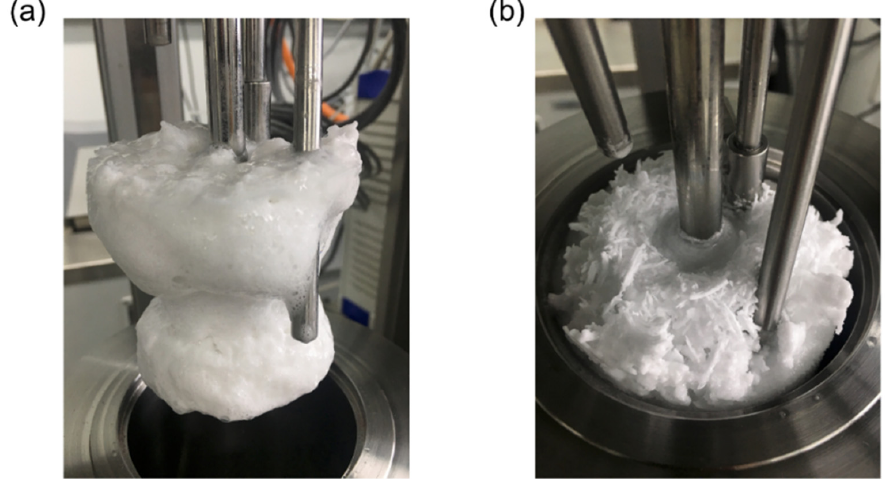
Figure 6. Pictures of hydrate formations in the reactor after finishing the experimental tests with ( a ) Span 80 and ( b ) the biodegradable AA candidates. The morphology of the hydrate growth with the lecithin or lanolin was observed to be di ff erent from that with Span